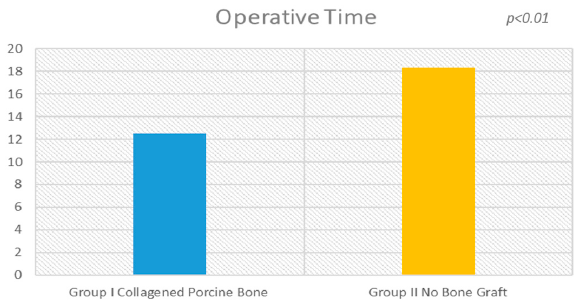
Figure 1. There is a statistical difference ( p < 0.01) between the operative times of the procedure between the experimental groups.